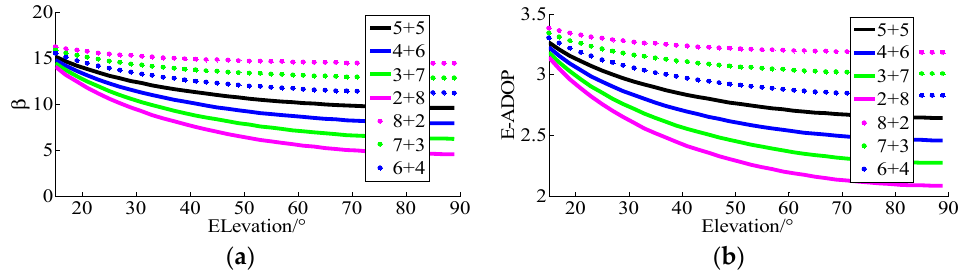
Figure 2. Factor β and E-ADOP of ten satellites for different elevations. ( a ) The β of ten satellites for different elevations. ( b ) The E-ADOP of ten satellites for different elevations.